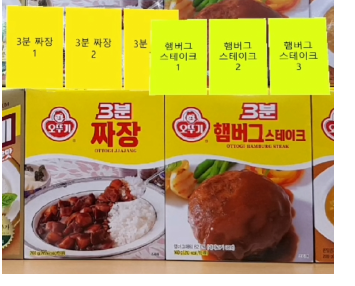
Figure 8. Overlap between AR